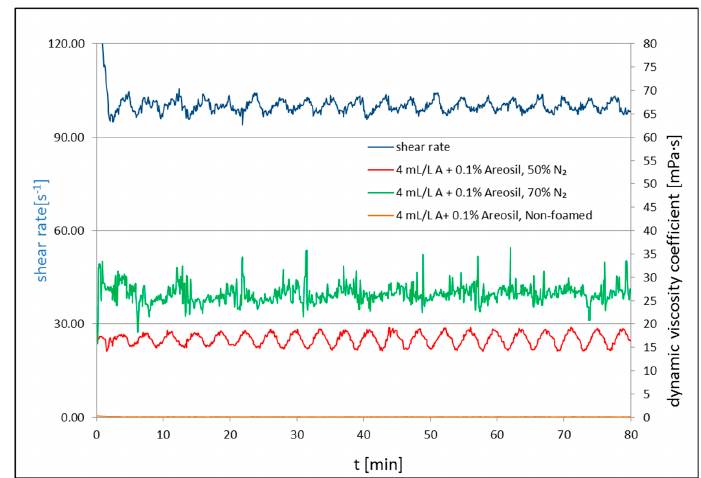
Figure 2. Viscosity of non-foamed and N 2 foamed fluid of 50% and 70% quality at 23 °C at a shear rate of 100 s − 1 .